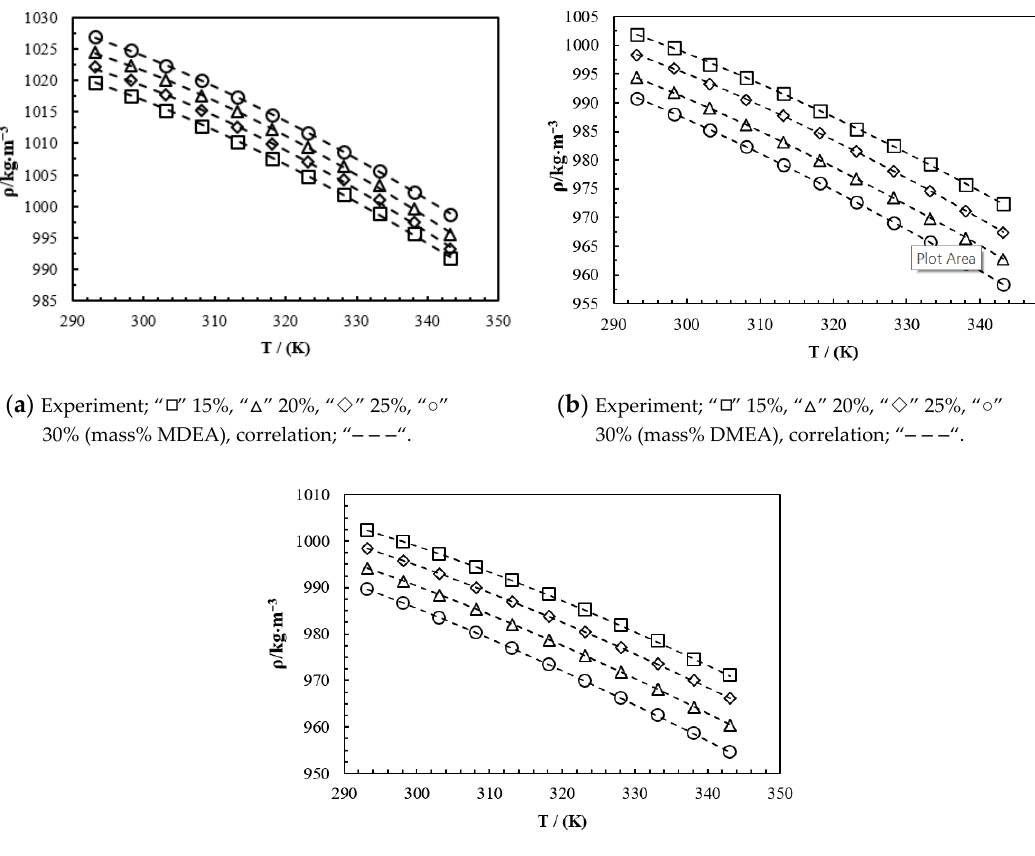
Figure 1. Density of: ( a ) MDEA + MEA + H 2 O, ( b ) DMEA + MEA + H 2 O, and ( c ) DEEA + MEA + H 2 O mixtures in the temperature range 293.15 K–343.15 K. Table 6. Binary parameters 𝐴 0 , 𝐴 1 , and 𝐴 2 of the equation 𝑉 𝑗𝑘𝐸 = 𝑥 𝑗 𝑥 𝑘 ∑ 𝐴 𝑖 (𝑥 𝑗 − 𝑥 𝑘 ) molar volume of MDEA (1) + MEA (2) + H 2 O